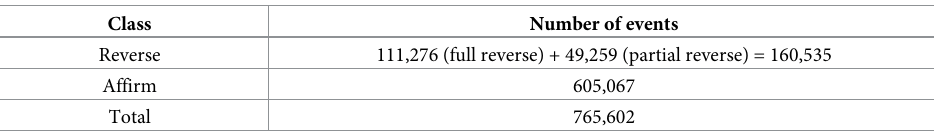
Table 1. Outcomes distribution on our